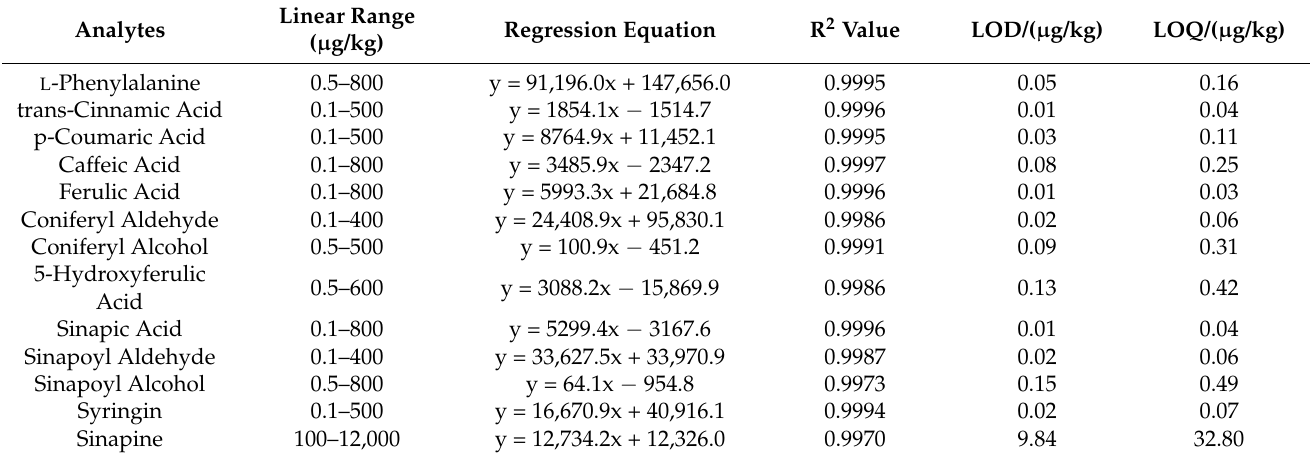
Table 1. Linear range, regression equation, determination coefficient (R 2 ), LODs, and LOQs of antioxidants.